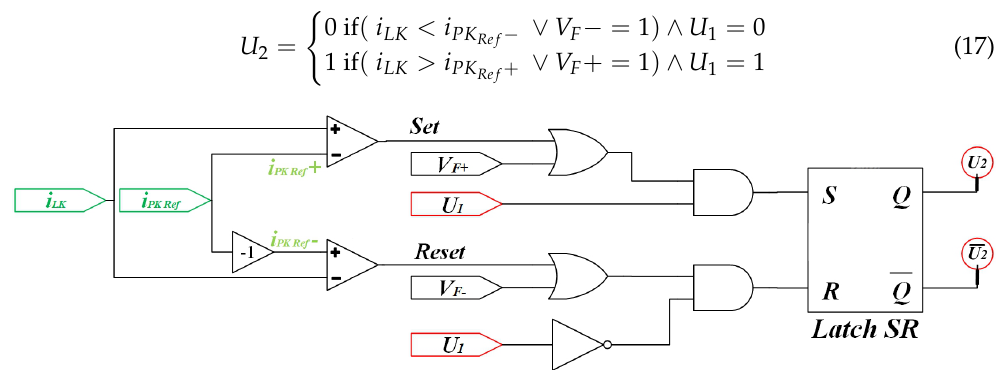
Figure 6. Peak current control of i LK